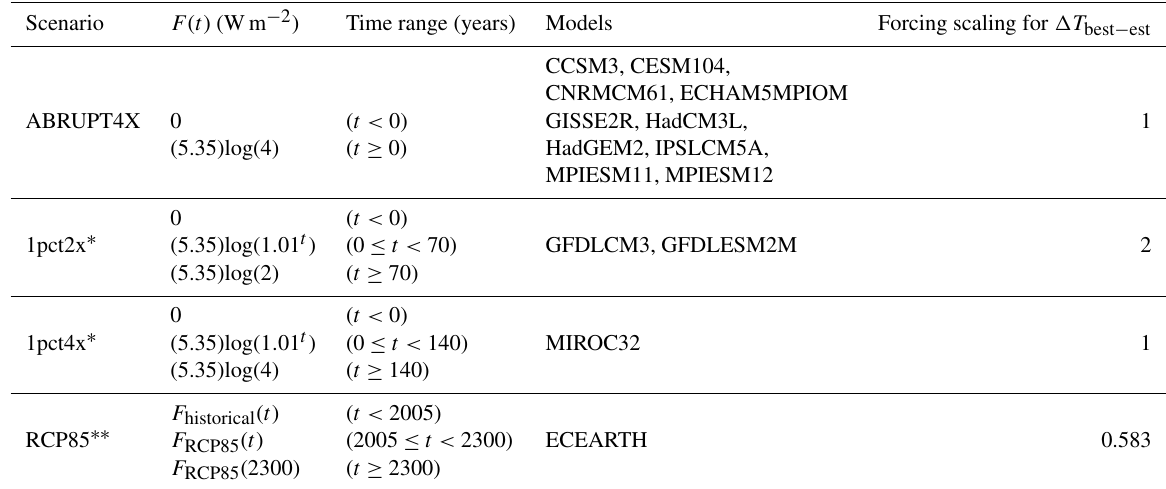
Table 3. Table showing assumed forcing evolution for experiments in LongRunMIP. ∗ Logarithmic CO 2 forcing dependency is assumed following Myhre et al. (1998). ∗∗ F historical ( t ) and F RCP85 ( t ) forcing are taken according to Meinshausen et al.